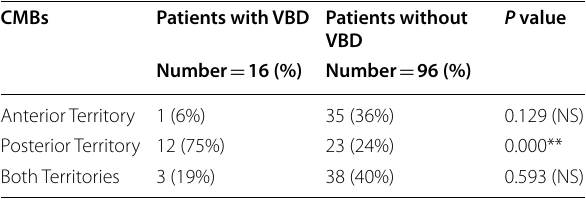
Table 5 Vertebrobasilar dolichoectasia and cerebral microbleeds territorial distribution